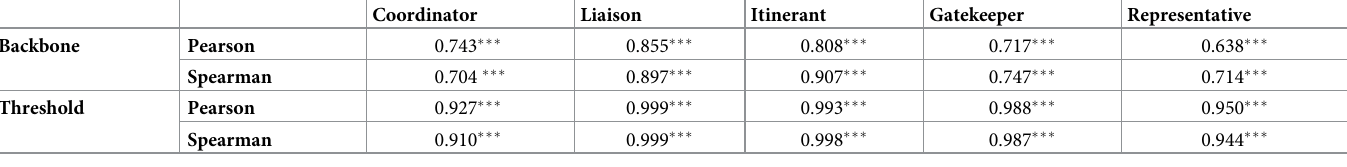
Table 2. Correlation analysis of WNGF results with the backbone and threshold network on the regional trade